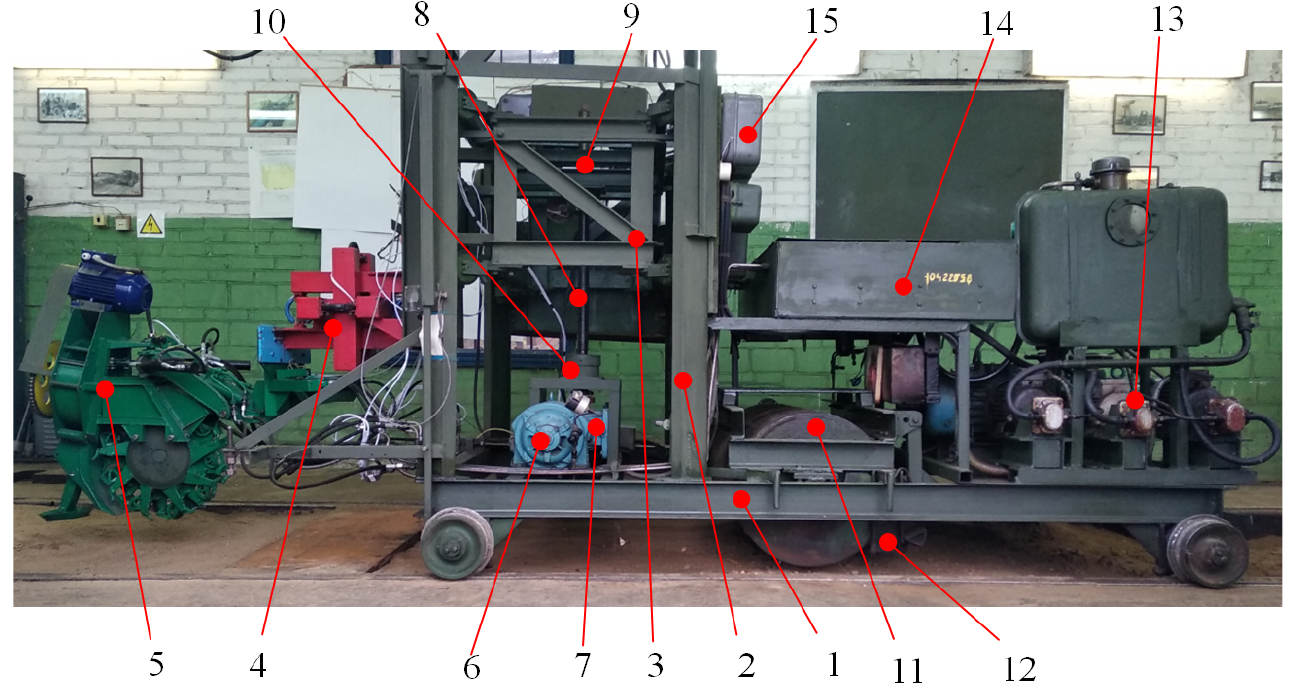
Figure 9. General view of the test bench with a model of the actuator (1—main frame; 2—frame;